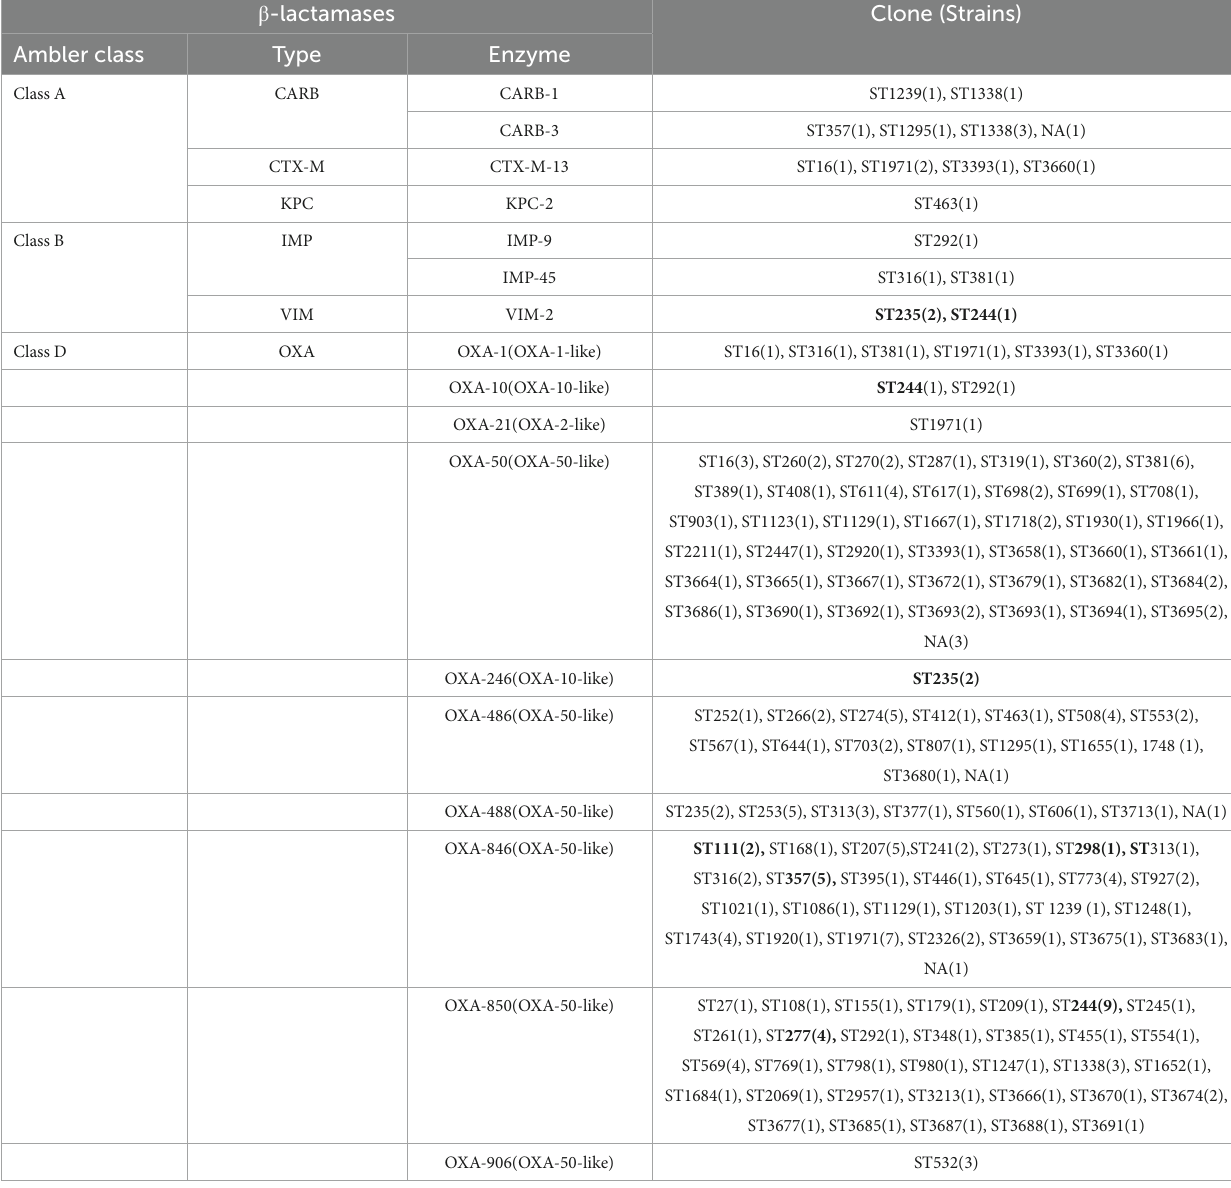
The bold values represent observed global P. aeruginosa high-risk